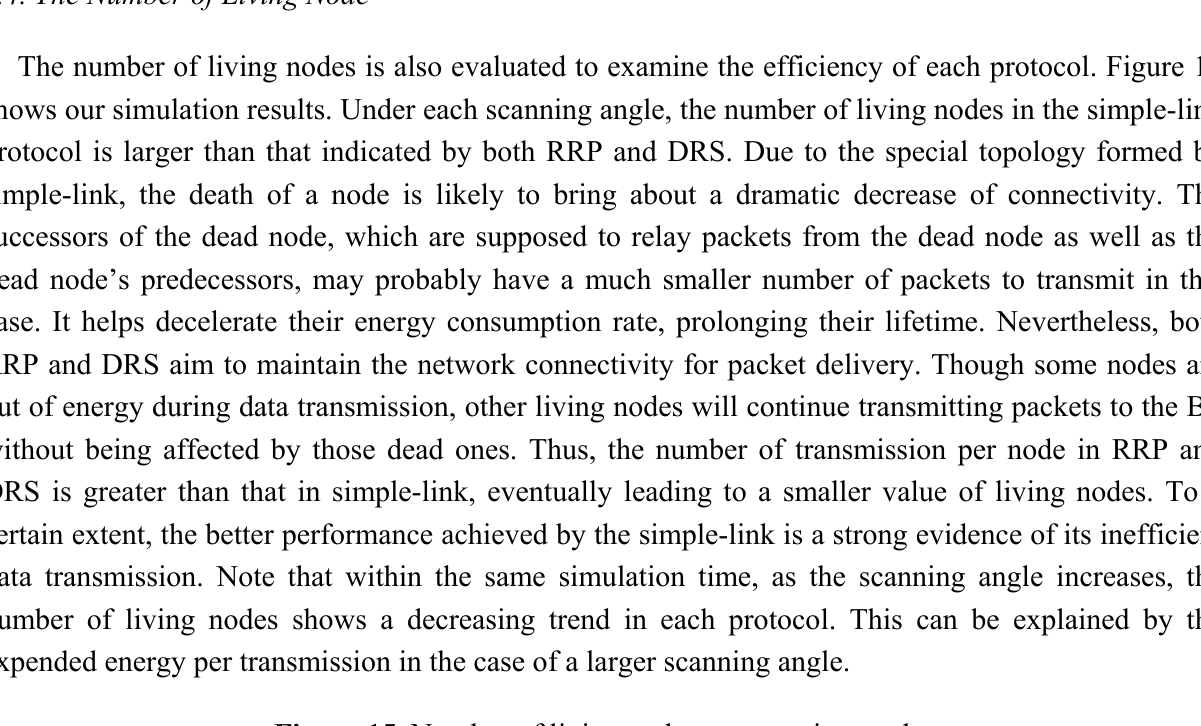
Figure 15. Number of living nodes vs. scanning